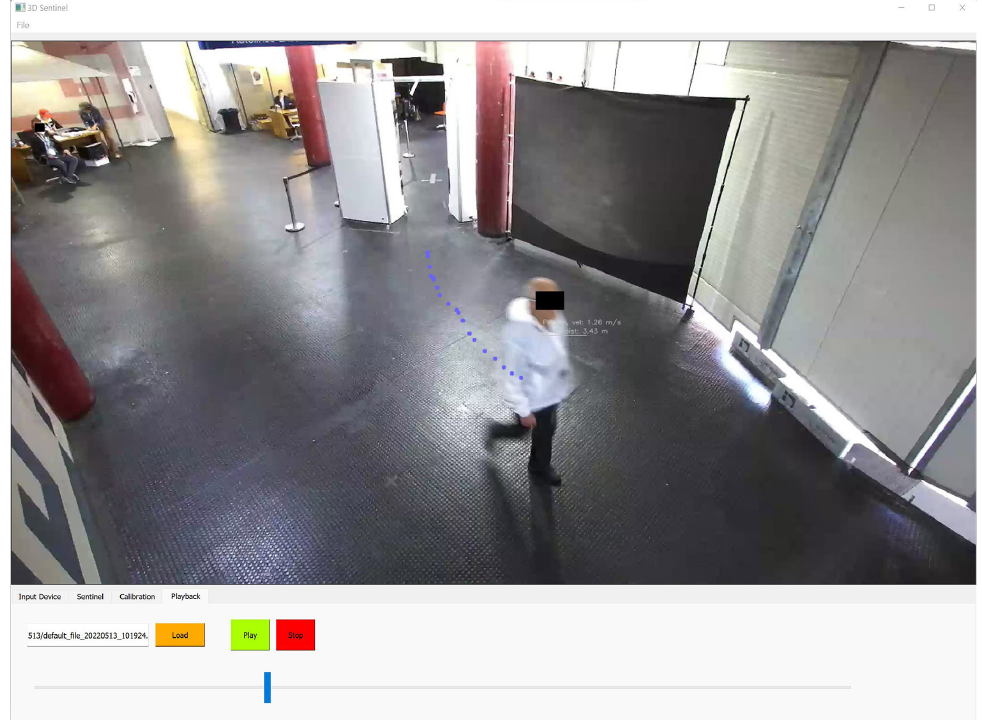
Figure 7. 3DSentinel software interface: the blue dots are the trace made by the detected person.